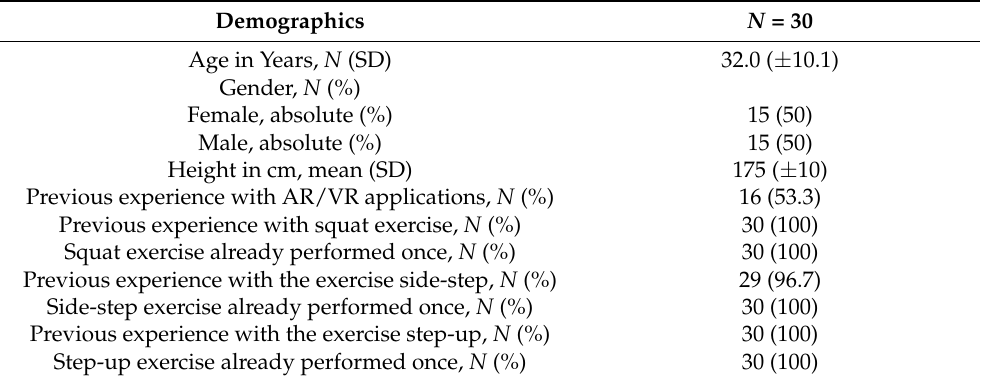
Table 1. Demographics of the study population. Annotation: N = sample size, SD = standard